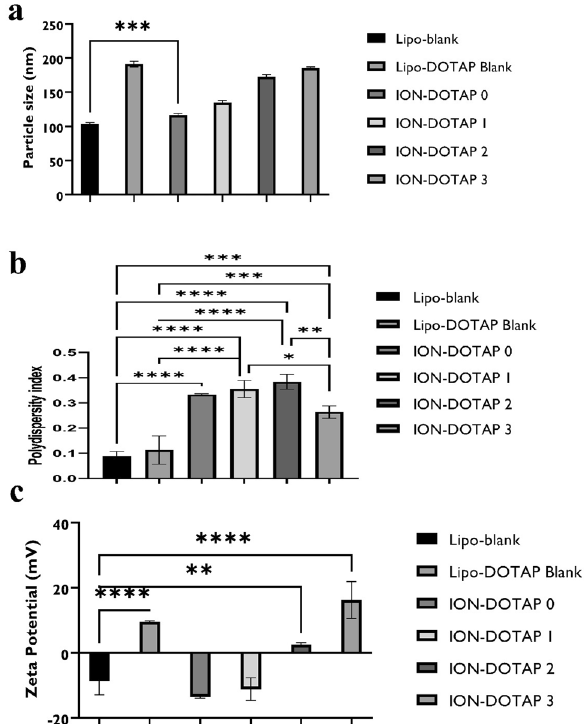
β-ionone, while Lipo-DOTAP Blank contained DOTAP at the highest concentration without the addition of β-ionone, * p < 0.5, ** p < 0.01, *** p < 0.001, compared to Lipo-Blank.